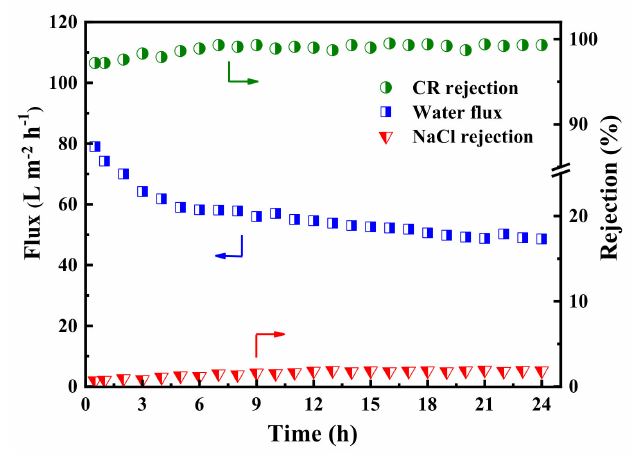
Figure 10. The long-term operation stability of the PES/Fe-TA3h membrane for the CR/NaCl mixture solution (feed: 0.1 g/L CR and 2 g/L